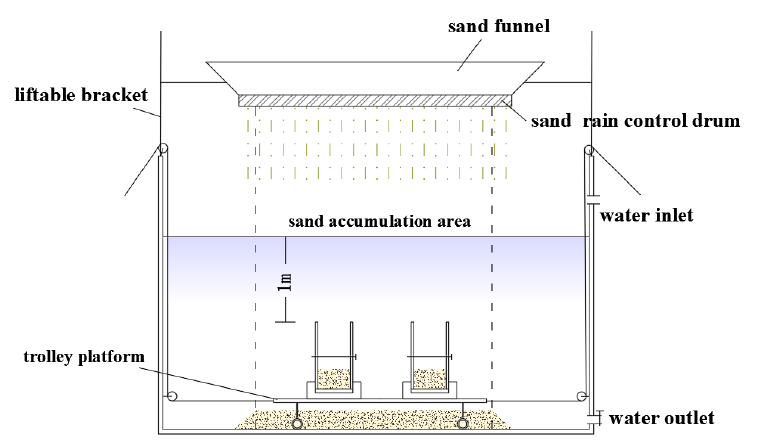
Figure 4. Sample preparation device of sand pluviation method for soil